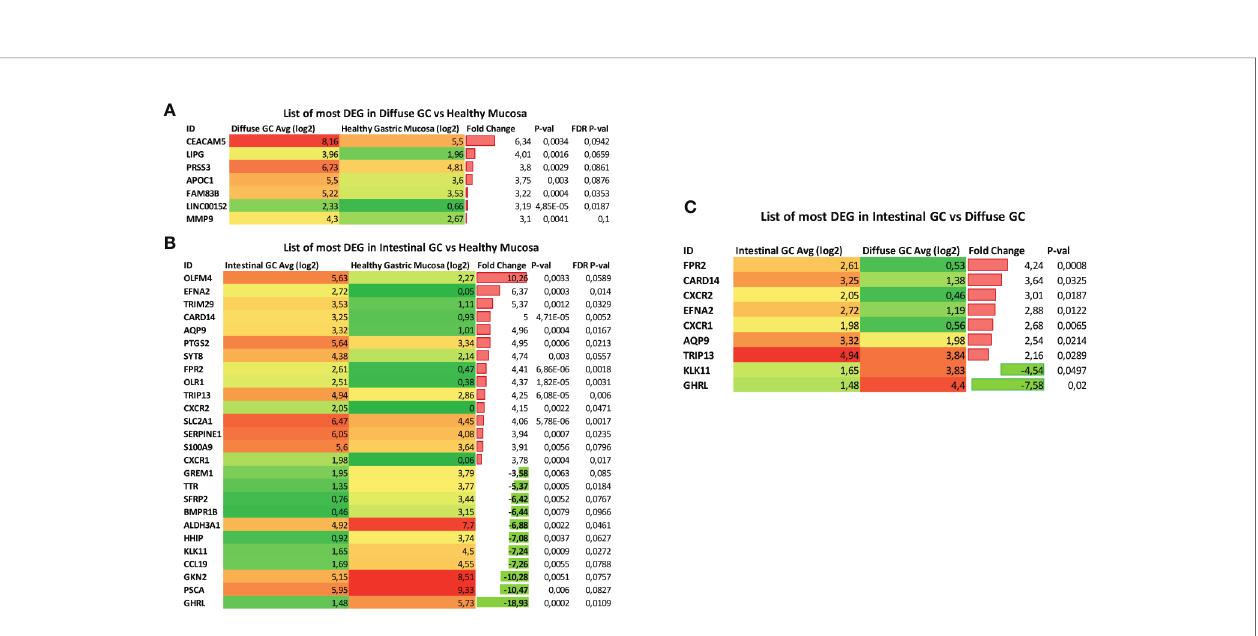
FIGURE 6 | Identi fi cation of Histotype-speci fi c genes. List of Differential Expressed Genes (DEGs) obtained using stringent criteria (threshold of FDR ≤ 0.1 and fold − change ≥ 3 applied) in (A) diffuse gastric cancer and (B) intestinal gastric cancer compared with healthy mucosa. (C) List of DEGs selected by using the stringent criteria between Intestinal gastric cancer and Diffuse gastric cancer samples.